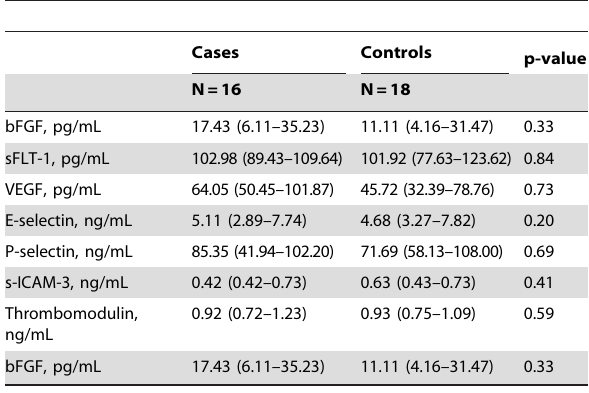
Table 2. Angiogenic risk factors in women with severe, very early onset preeclampsia and